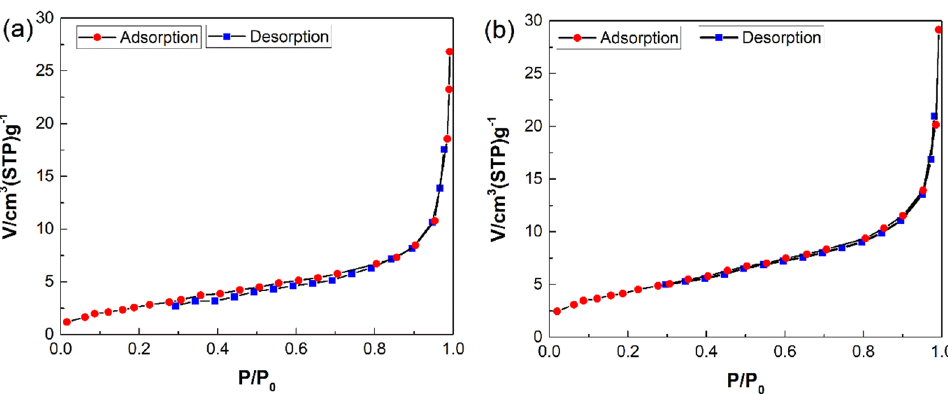
Figure 3. N 2 adsorption/desorption isotherms of PmPDA ( a ) and PmPDA@ZnO ( b